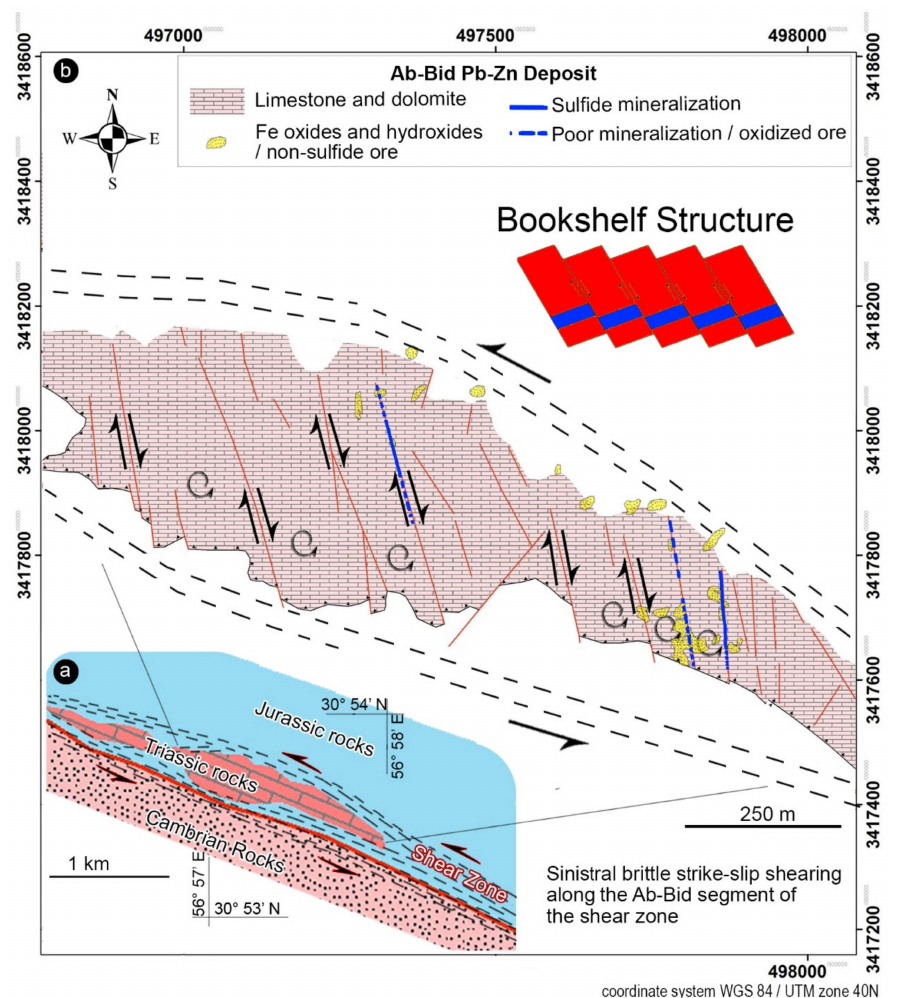
Figure 15. ( a ) A sinistral brittle strike-slip shearing along the Ab-Bid segment of the shear zone (dotted lines). ( b ) Illustration of the bookshelf structure in carbonate host rocks of the Ab-Bid deposit and structural control of sulfide